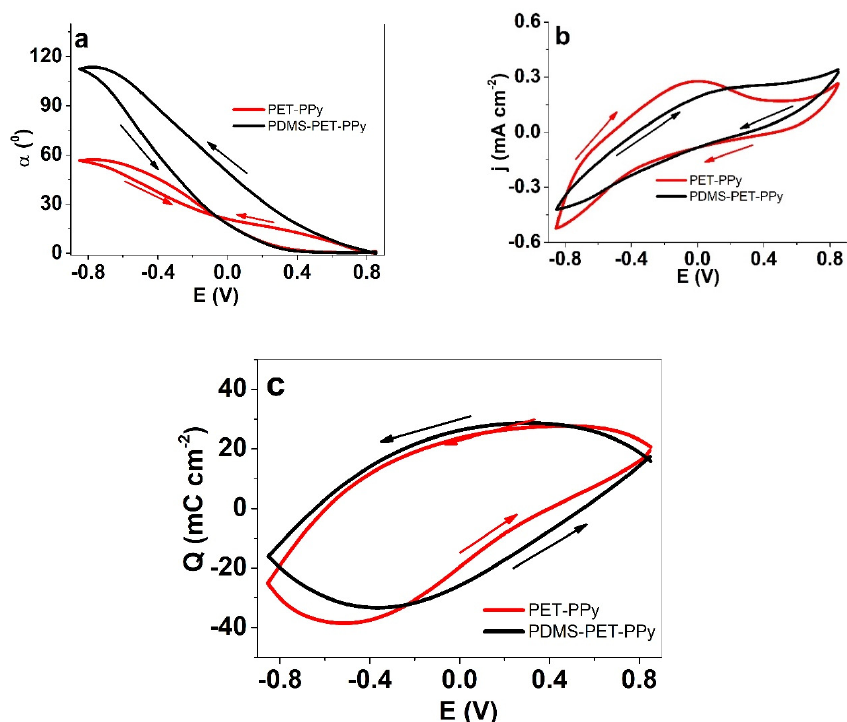
Figure 4. Cyclic voltammetry (scan rate 10 mV s − 1 , third cycle) in potential window of ± 0.85 V in aqueous mixed electrolyte (TMACl + NaDBS) of PET-PPy (red line) and (PDMS) PET-PPy bilayer (black line) showing ( a ) the angular displacement α , ( b ) the current density j , and ( c ) the charge density Q against potential E . The arrows indicate the direction of the scan.